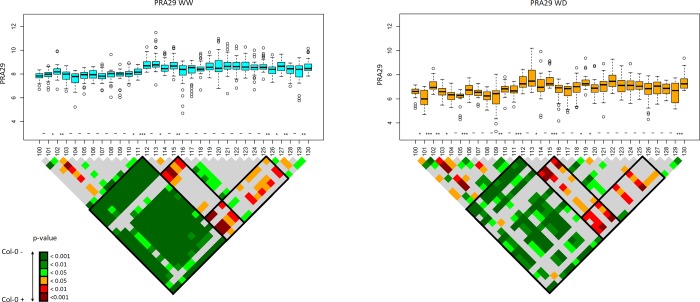
Dissection of a genomic region in CvixCol for PRA29 ('microStairs' approach).The upper panels' are quartile boxplots indicating phenotypic values observed for each of the 31 successive recombinant lines along the 3Mb region studied (details of each line used here are in S4 Table). Significant differences between successive lines (stairs) are indicated along the X axis with '*' (p-value < 0.05), '**' (p-value < 0.01), '***' (p-value < 0.001) or '-' for no significant difference. The lower panel shows a triangular matrix gathering the significance of all pairwise comparisons between lines (see the p-value color scale also indicating the direction of the allelic effect). Blocks of significance ('staircase') are interpreted and highlighted in black-framed boxes. This figure shows results obtained for trait PRA29 only (in 2 conditions), PRA is expressed in cm2; other traits are in S7 Fig.